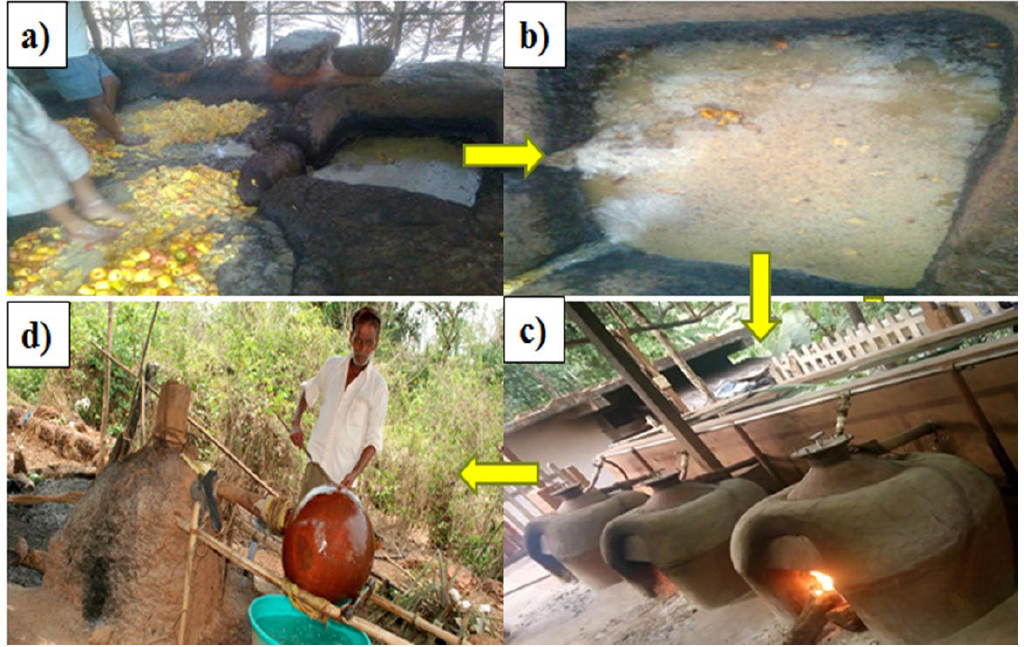
Fig. 1 (a-d). Traditional Feni making process. (a) Manual crushing (b) Juice collection tank (c) Distillation still (d) Distillate